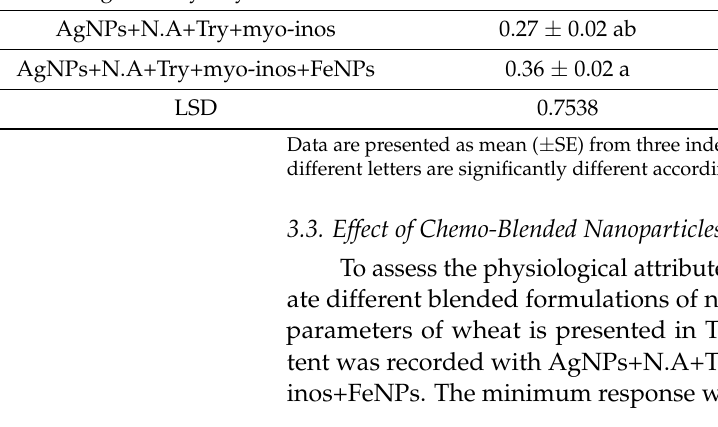
Table 3. Effect of different treatments of blended NPs on physiological parameters of